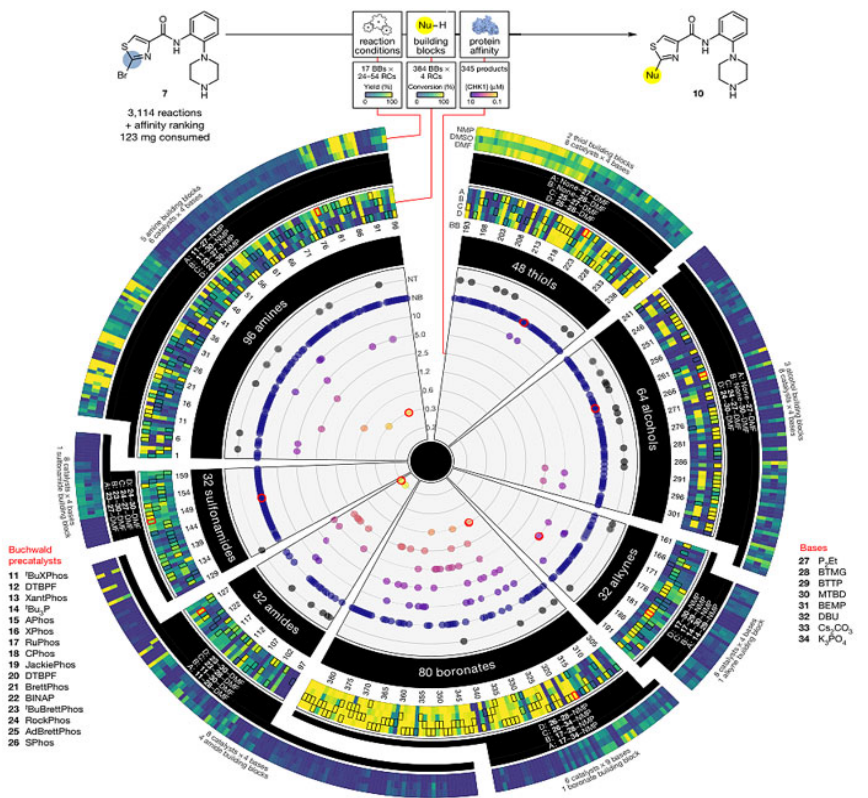
Figure 3. NanoSAR technology for high-throughput screening of CHK1 inhibitors and their synthesis conditions. Reprinted with permission from ref. [49]. Copyright 2018, Springer Nature.